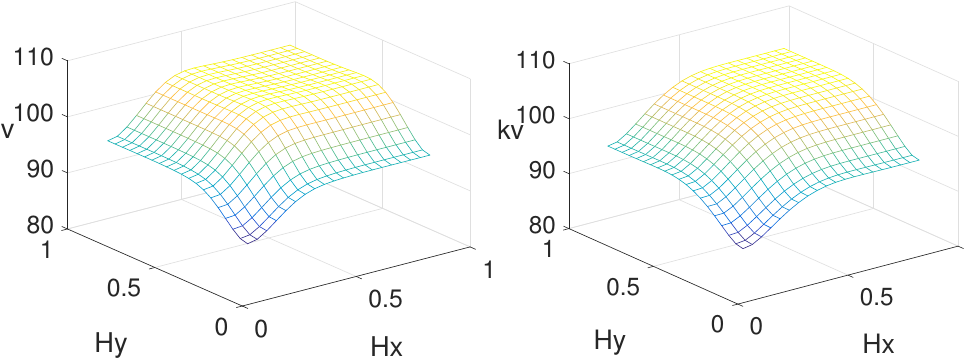
Figure 5. The effect of different H x and H y on v and kv when ( x , y ) = ( 100,100 ) .